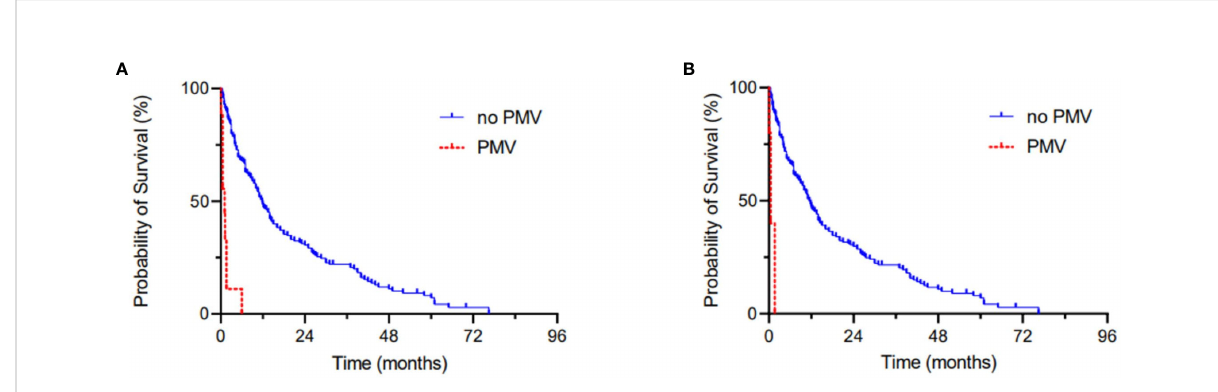
FIGURE 2 Kaplan-Meier survival analyses dependent on the occurrence of postoperative PMV > 48 hrs (A) and > 72 hrs (B)